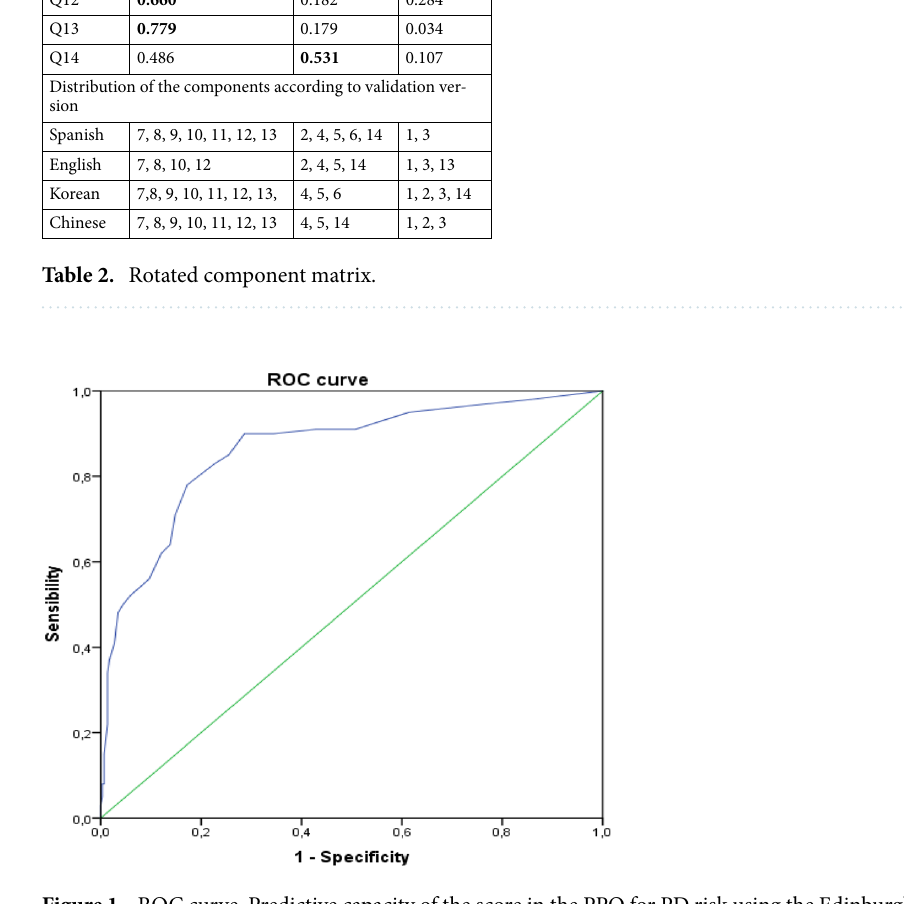
Figure 1. ROC curve. Predictive capacity of the score in the PPQ for PD risk using the Edinburgh